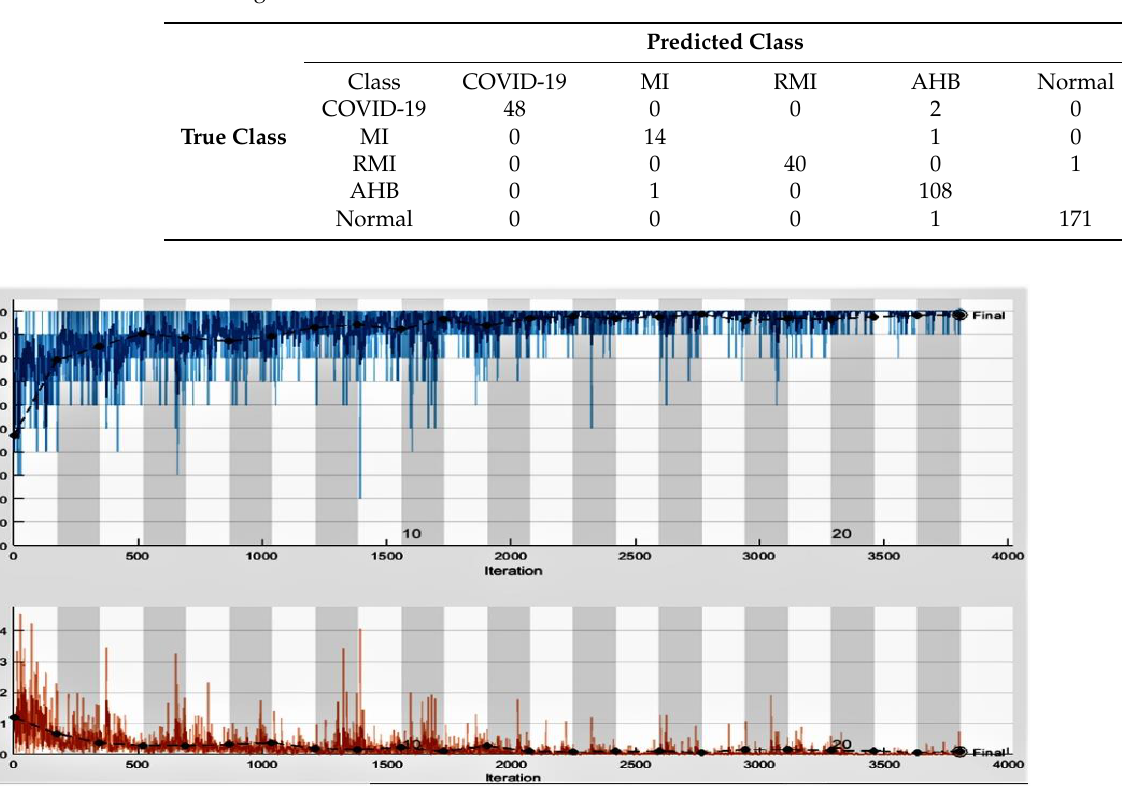
Figure 8. Training and testing accuracy and loss plots of five-class classification (black line shows the testing accuracy and loss) using ECG trace images dataset. Table 11. Performance evaluation on ECG Images dataset of Cardiac and COVID-19 Patients multi- class